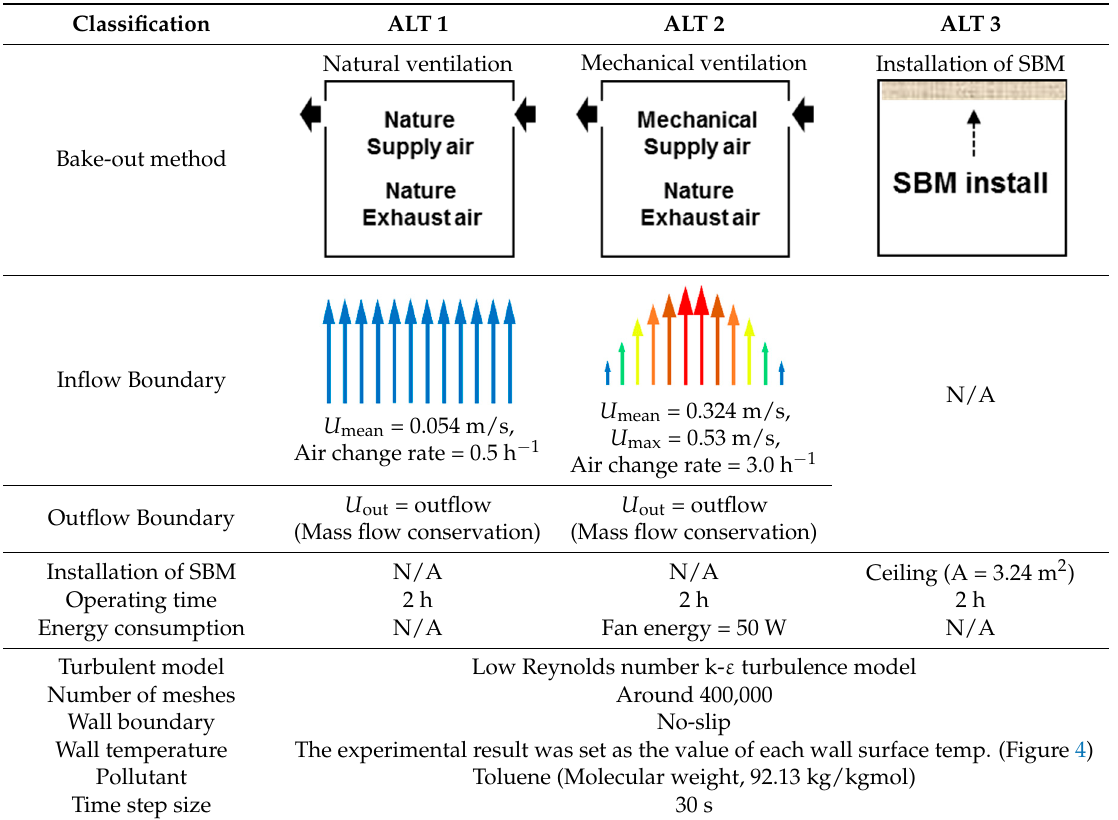
Table 4. Boundary condition of CFD (computational fluid dynamics) analysis for bake-out.